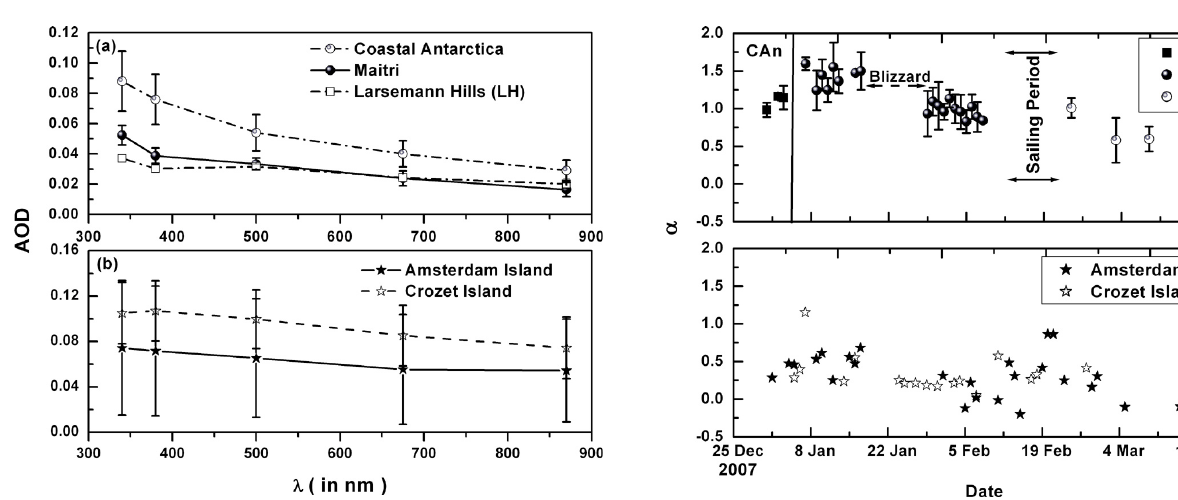
Fig. 6. Daily mean values of Angstrom parameters α at Maitri, LH (in top panel), Amsterdam and Crozet Island (in bottom panel). The vertical line in the top panel shows the standard deviation from the mean